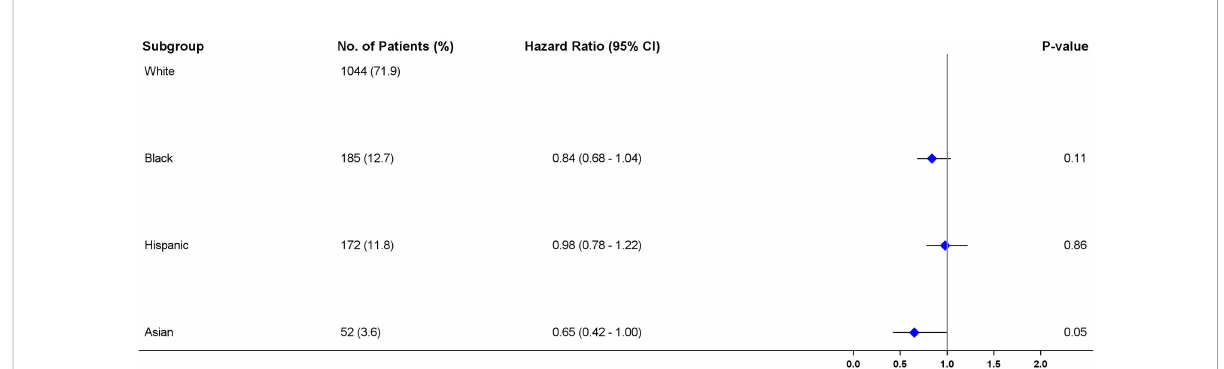
FIGURE 3 Forest plot of multivariable Cox proportional hazard regression analysis showing the association between patient characteristics and disease- speci fi c survival using regression